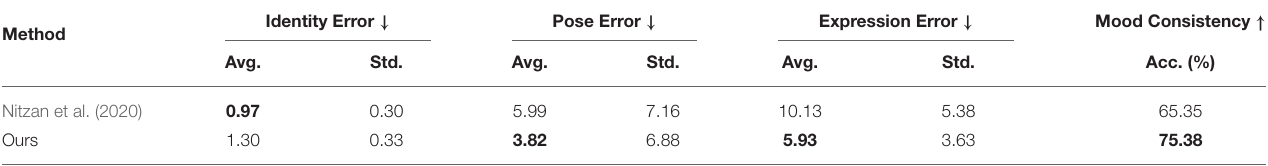
TABLE 1 | Quantitative comparison with Nitzan et al. (2020). Our method performs better in most indicators. Method